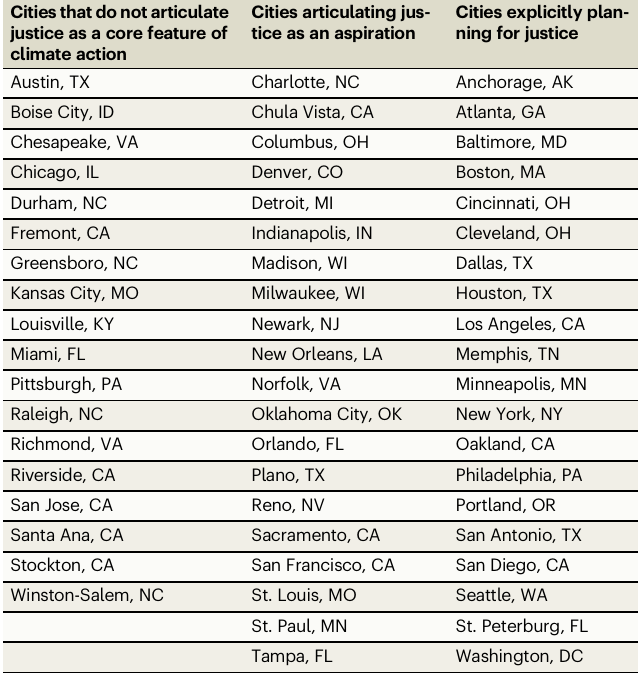
Table 1 | Cities categorised by their level of engagement with justice in their climate action